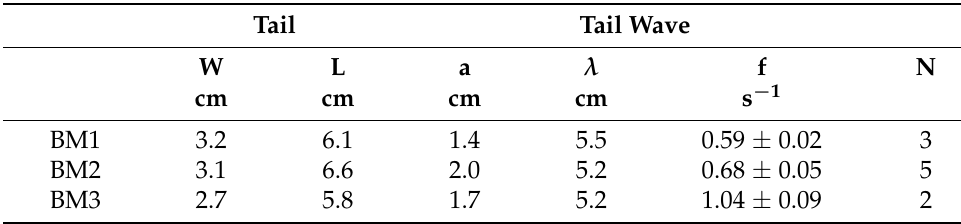
Figure 1. In-situ video frame grabs. ( A ) Bathochordaeus mcnutti inside its mucus house viewed under white lighting. The white rectangle indicates the area shown in ( B ), which is a close-up view of the animal, illuminated by the laser. Measured tail wave characteristics λ (wavelength) and a (amplitude) are shown. Table 3. Kinematics results from in situ observations of Bathochordaeus mcnutti . Shown are tail width (W), tail length (L), amplitude (a), wavelength ( λ ), frequency (f), and number of consecutive tail beats (N) used for measurement of the kinematics. Modified from Reference